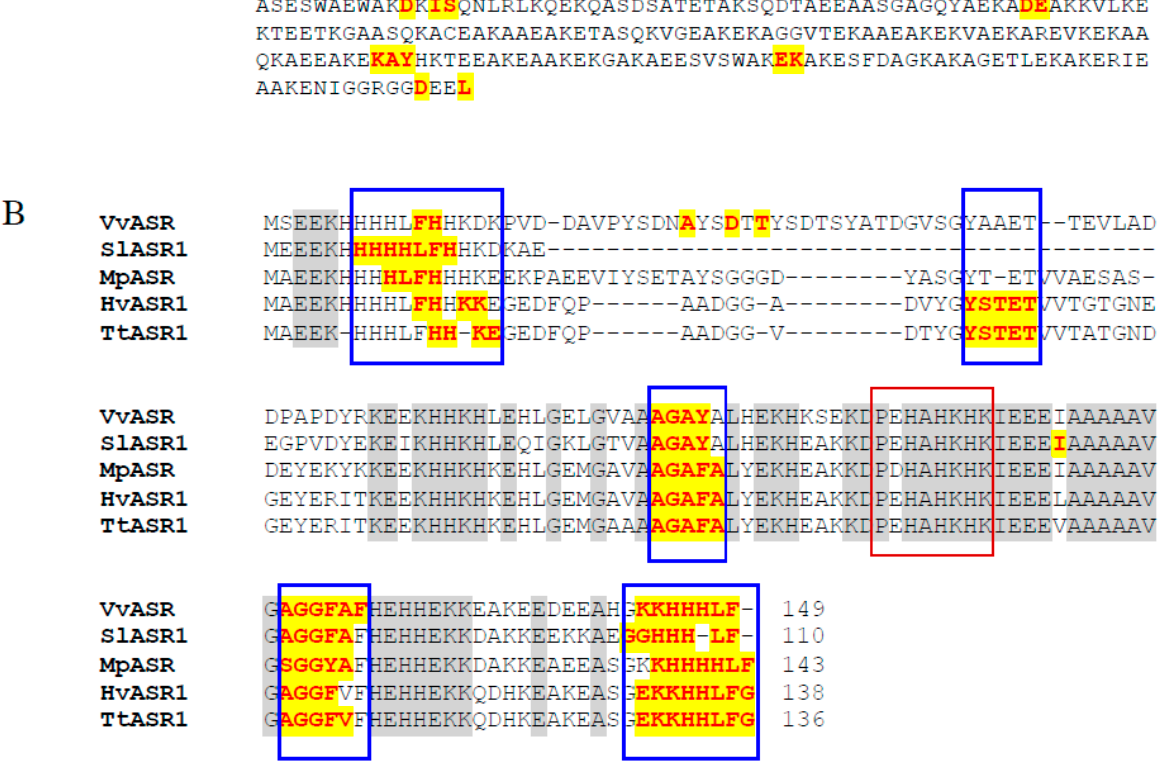
Figure 5. Prediction of the intrinsically disordered regions by MoRFpred. ( A ) Identification of Molecular Recognition Elements (MOREs) in the sequence of VvLEA D-29. ( B ) Multiple sequence alignment of five ASRs with their predicted intrinsically disordered regions: VvMSA ( Vitis vinifera ); SlASR ( Solanum lycopersicum ); MpASR ( Musa ABB Group); HvASR1 ( Hordeum vulgare ); TtASR1 ( Triticum turgidum subsp. Durum ). The amino acids in bold, red, and highlighted in yellow denote the short disorder-to-order transitioning binding regions (blue frame). The amino acids in normal, black and highlighted in gray are identical in all of the five ASR sequences. The Zn 2+ -binding region PEHAHKHK (red frame) is identical in grape, tomato, plantain, barley and wheat.